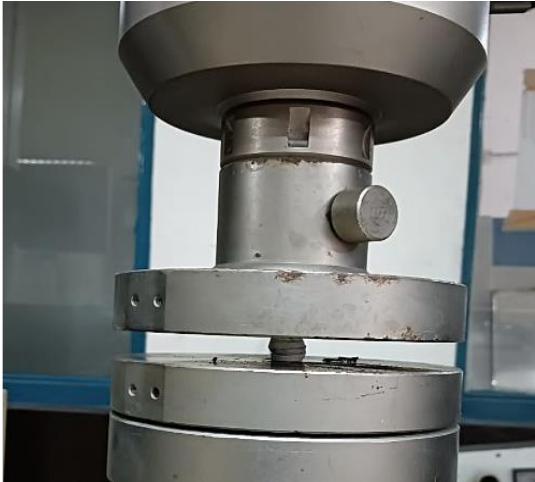
Figure 2. A sample under compression testing on the UTM machine.